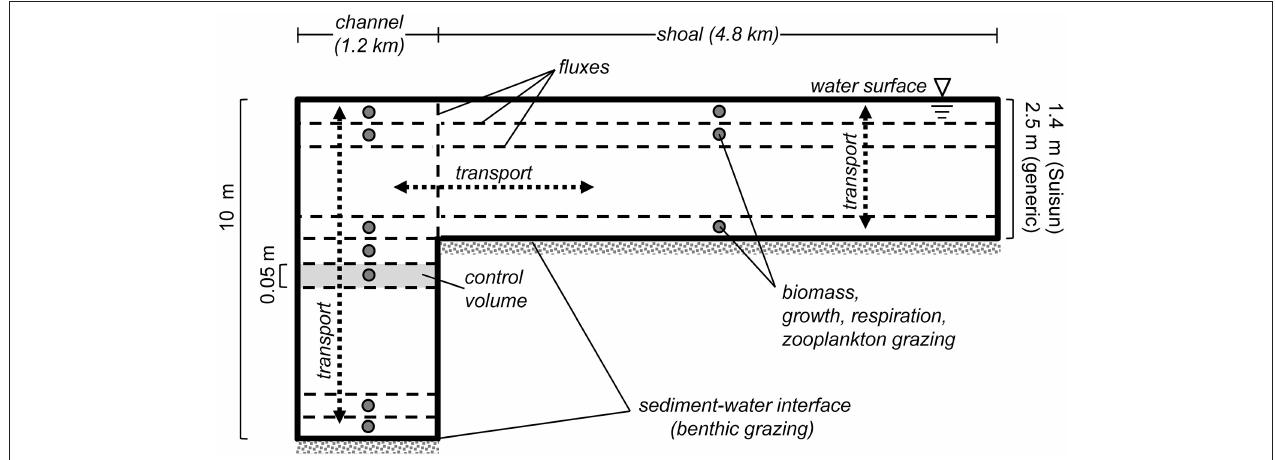
FIGURE 2 | PS2D model schematic. Sketch describes the staggered grid layout of the PS2D phytoplankton model. The model computes phytoplankton biomass in adjacent channel and shoal water columns, which can exchange mass horizontally. Phytoplankton biomass, growth, respiration and zooplankton grazing are defined at cell (or “control volume”) centers, and advective and diffusive flux terms are computed at cell faces. Benthic grazing is treated as an advective flux at the bottom face of the bottom cell of each water column. Within each of the two water columns, phytoplankton biomass is treated as vertically variable but horizontally homogeneous. Not to scale.